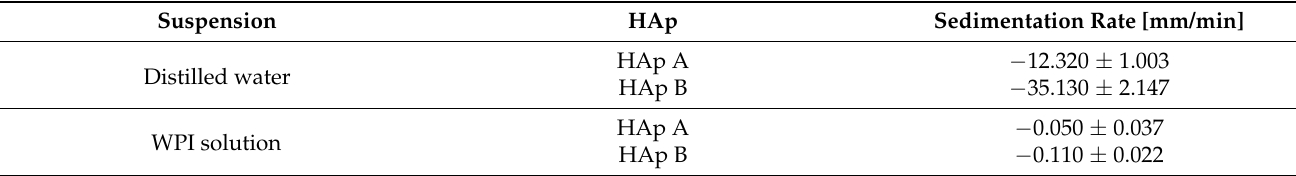
Table 9. Sedimentation rate for HAp powder in different